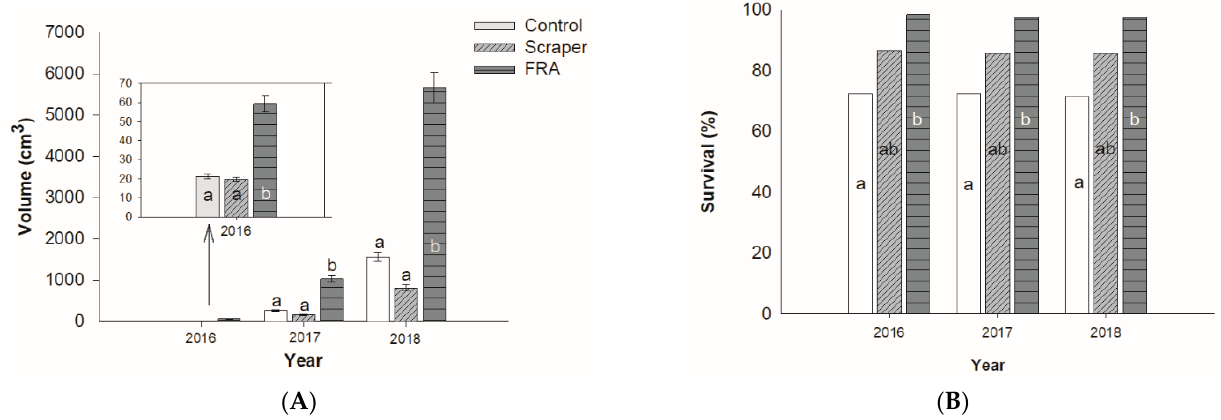
Figure 5. Mean tree seedling volumes by treatment with standard error bars ( A ) and mean survival rates by treatment ( B ). Shared letters are not statistically different ( α = 0.05).